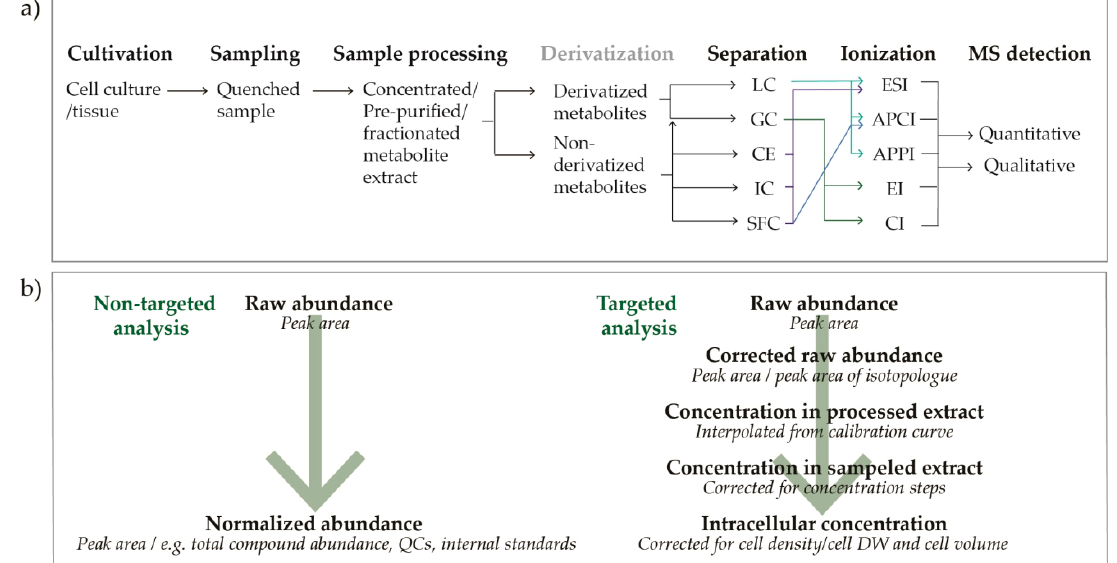
Figure 1. Mass spectrometry-based metabolomics workflow ( a ) from cultivation to detection, and ( b ) from raw abundance to normalized abundance (non-targeted analysis) or intracellular concentration (targeted analysis). LC, liquid chromatography; GC, gas chromatography; CE, Capillary electrophoresis; IC, Ion chromatography; SFC, Supercritical fluid chromatography; ESI, electrospray ionization; APCI, atmospheric pressure chemical ionization; APPI, atmospheric pressure photoionization; EI, electron ionization; CI, chemical ionization; MS, mass spectrometry; QC, quality control; DW, dry weight.